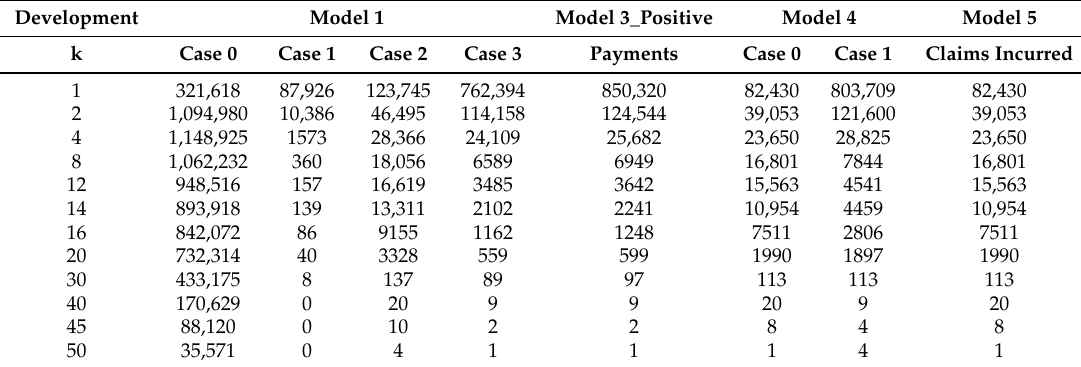
Table 1. Number of observations available for estimating the regression models for development periods k ≥